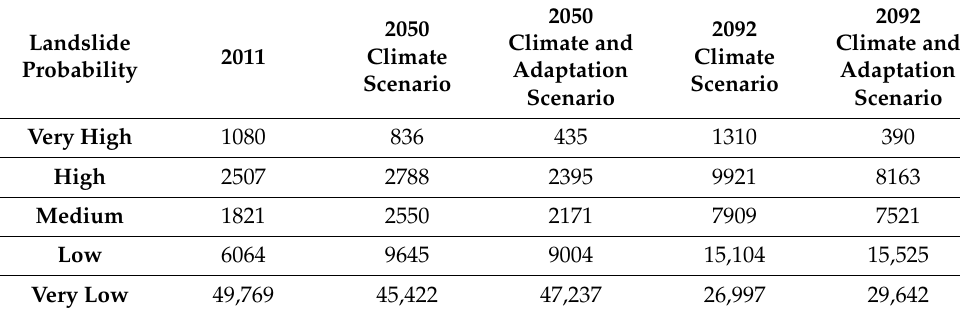
Figure 7. Landslide probability of 2092: ( a ) only climate scenario applied, and ( b ) both climate and adaptive scenarios applied. 3.3. Assessing Landslide Risk under Climate and Adaptive Scenarios As a result of predicting the landslide probability by adding the adaptation scenario to the future climate scenario, the decrease in the Very High risk area was remarkable. However, the application of the forest-related adaptive scenario in 2050 did not show any significant difference at the national scale, although a detailed regional difference was